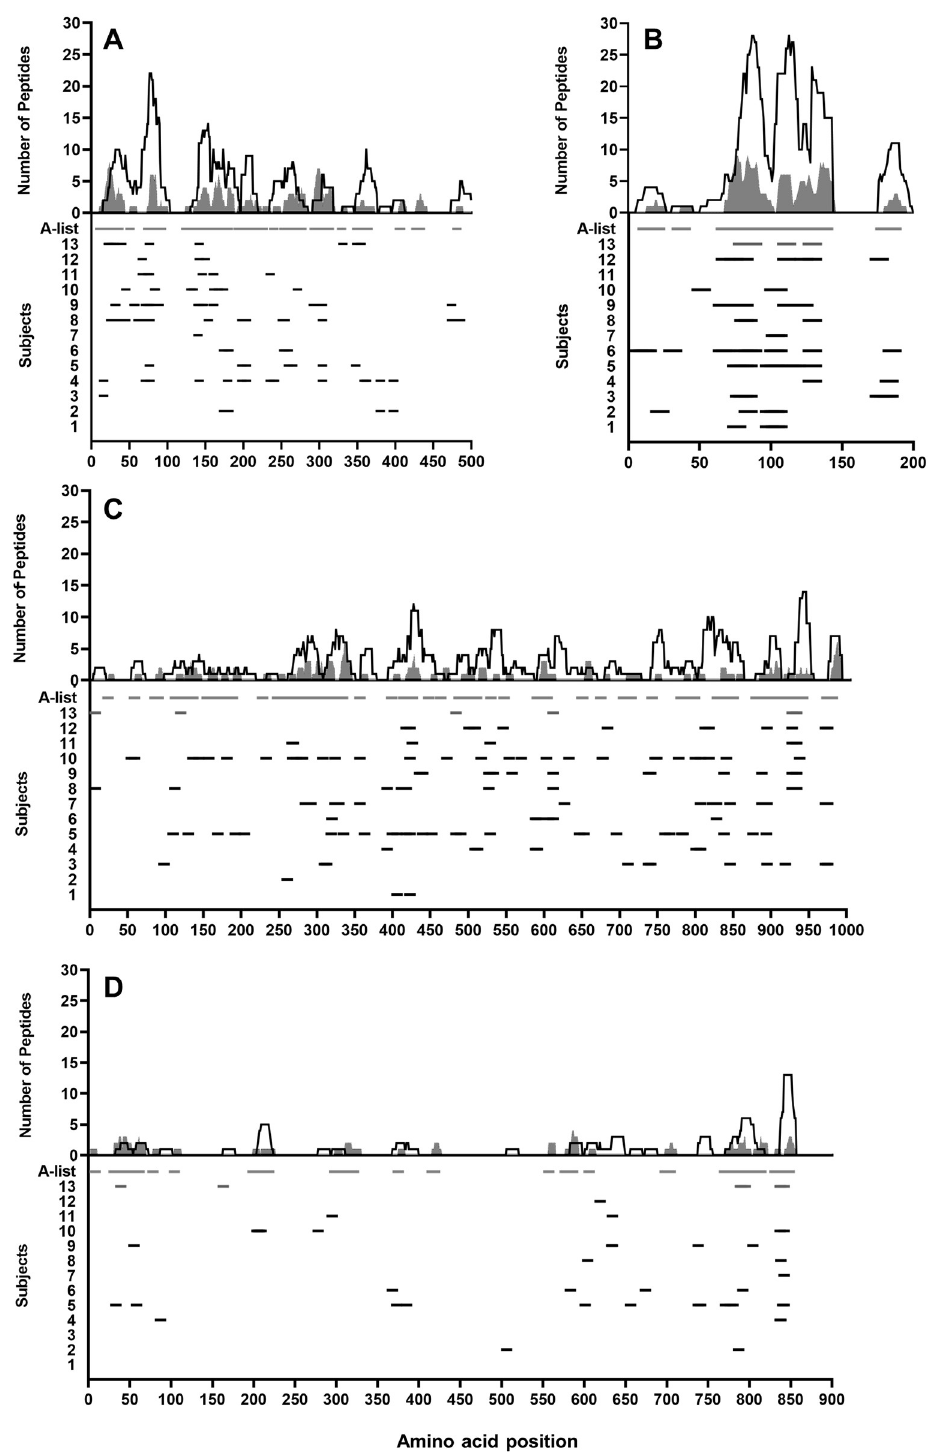
Fig 1. Locations of PTE peptides recognised compared with A-list epitopes across HIV-1 proteins. The x-axes represent HXB2 HIV-1 protein amino acid sequence position for each of the four represented proteins. The upper y- axes display the number of times an amino acid at each HXB2 amino acid sequence position is present in peptides recognised by the present study subjects (open area) compared with the A-list of known epitopes (shaded area). The lower y-axes display the study subjects and locations of peptide responses (black dash) as well as A-list epitope locations (shaded dash). (A) HIV-1 Gag protein (B) HIV-1 Nef protein (C) HIV-1 Pol protein (D) HIV-1 Env protein.